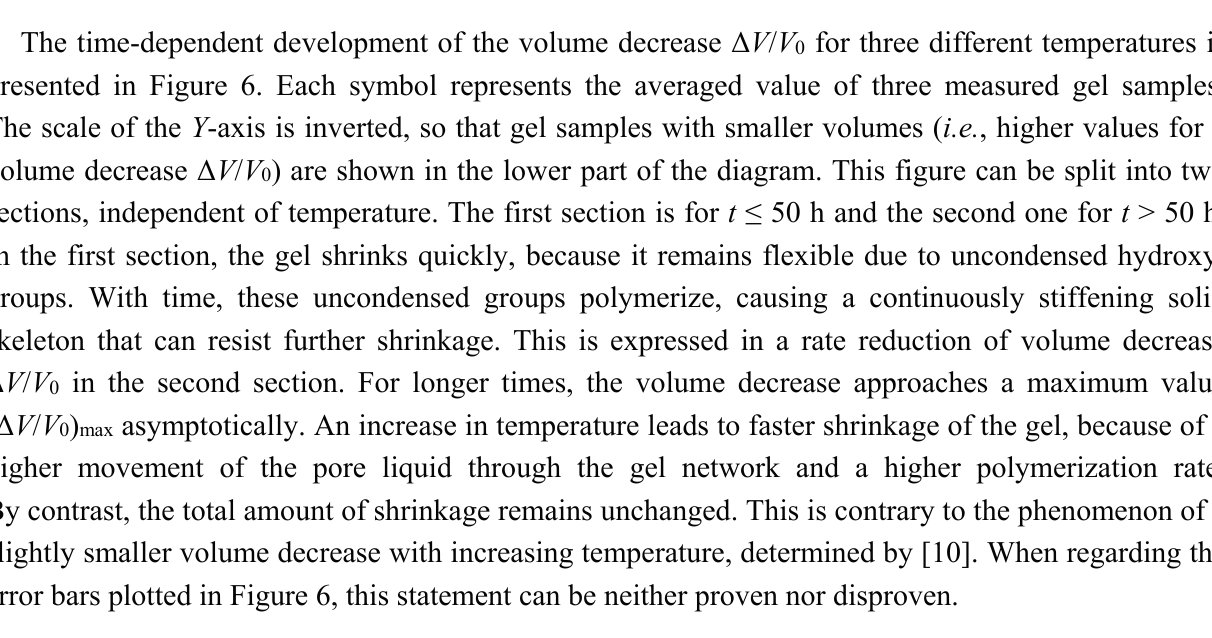
Figure 6. Volume decrease for different temperatures, natural